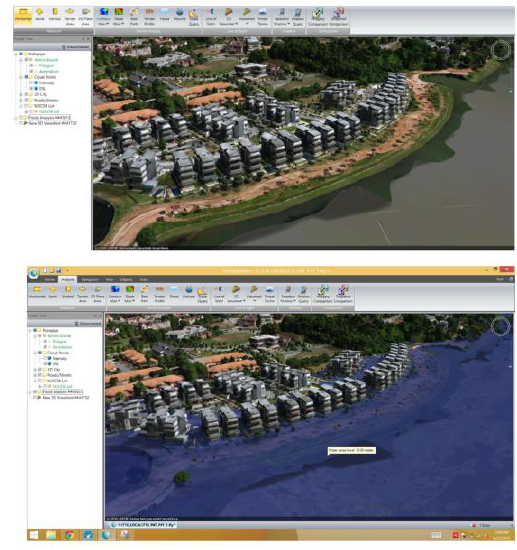
Figure 4 Flood anlysis based on 3D City Model of FT Putrajaya via